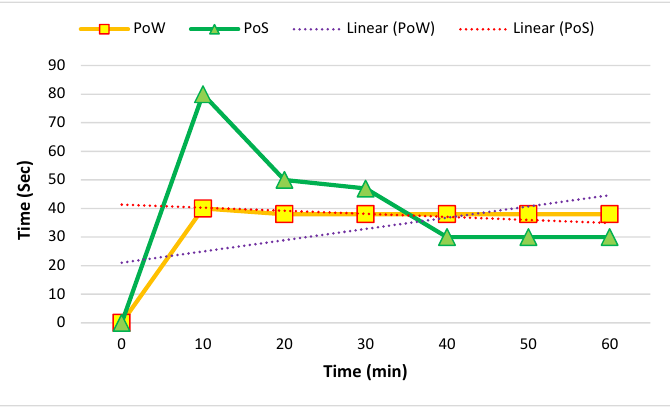
Figure 11. Average mining time in ten nodes in one hour.